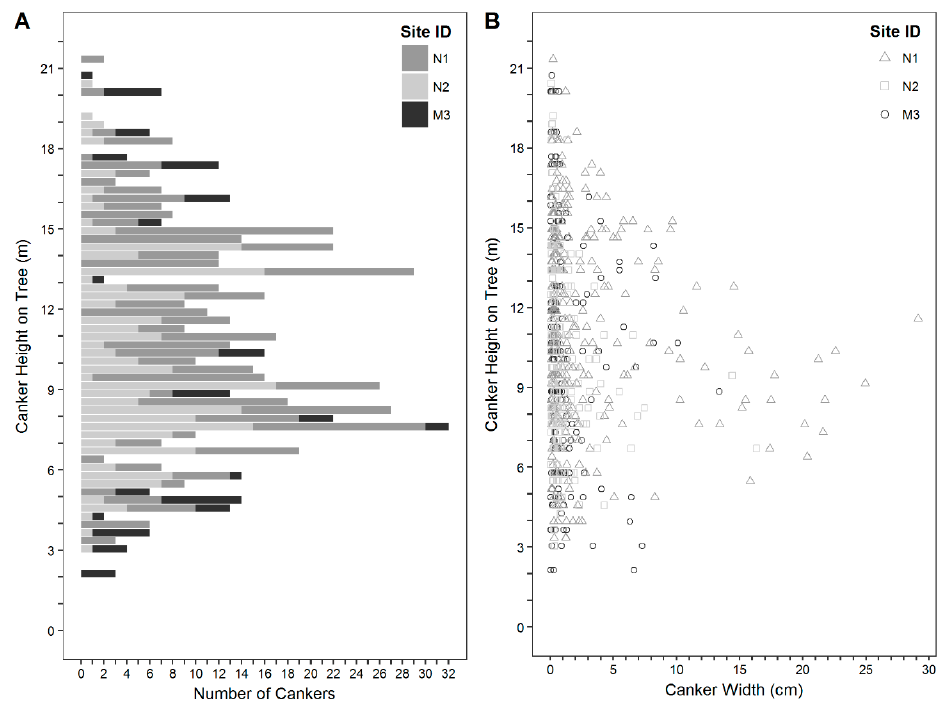
Figure 4. Tree height and Caliciopsis canker damage relationships conveyed via the ( A ) number of cankers and ( B ) the width of cankers at each 0.3 m height on the tree.